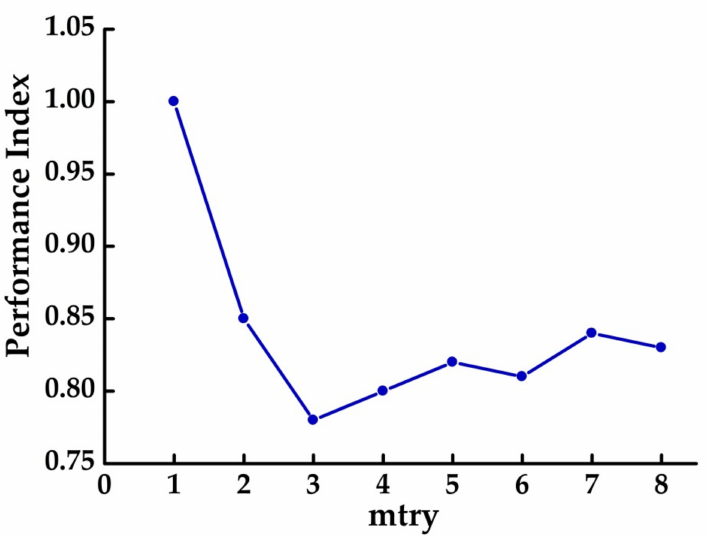
Figure 5. Results for RF trained with di ff erent number of randomly selected variables to grow the tree ( mtry)